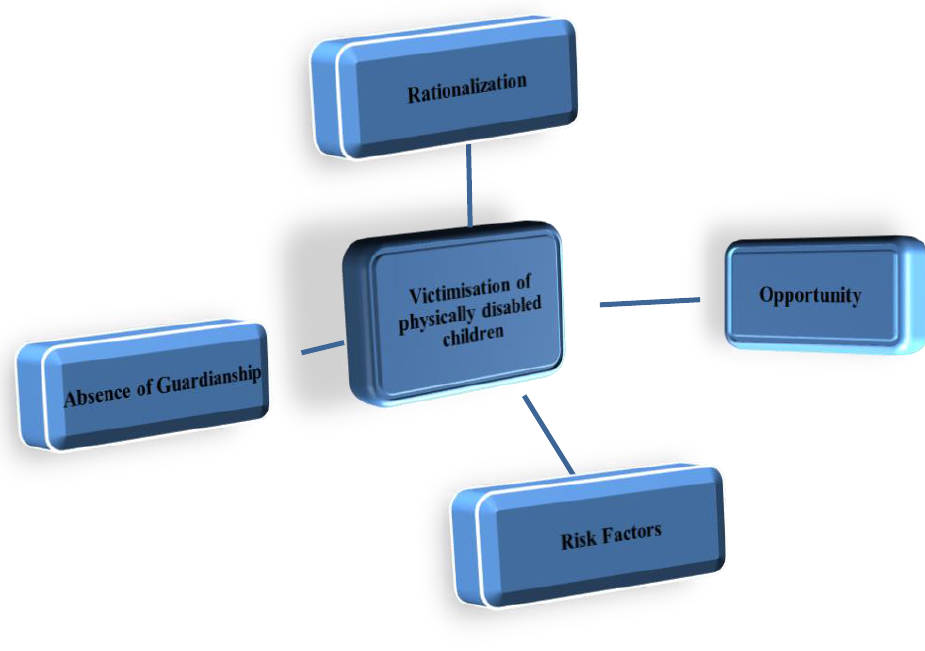
Figure 1: Integrated model of physically disabled children; Source: Sibayoni